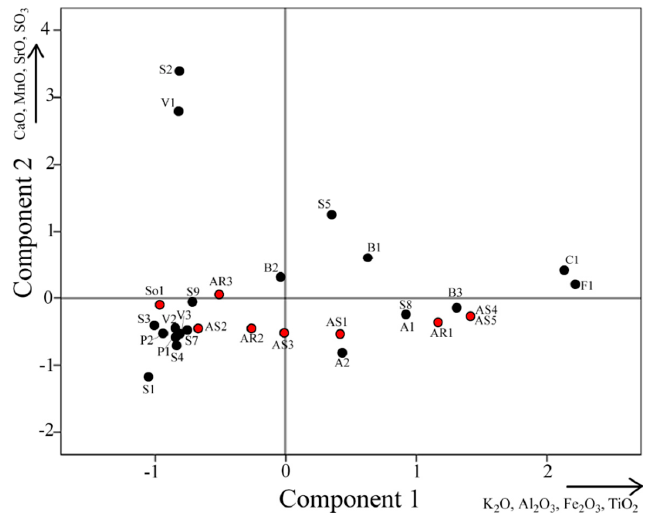
Figure 11. Plot of components 1 and 2. Black dots represent the coastal outcrops and red dots represent the inland